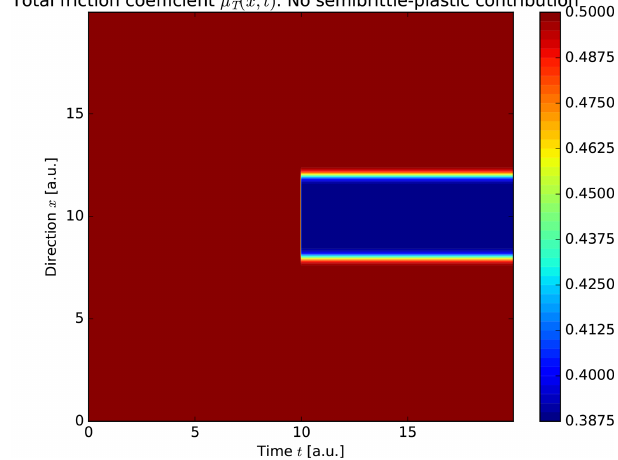
Figure 10. Total friction coefficient using no semibrittle–plastic contribution. That is γ(x) = 0, ∀ x ∈ [ 0 , 2 x half ] . The friction vari- ation exists only when the earthquake occurs ( t = 10a.u.) and at the earthquake rupture place ( (cid:49)τ ∈ [ 8 , 12 ] a.u. in this